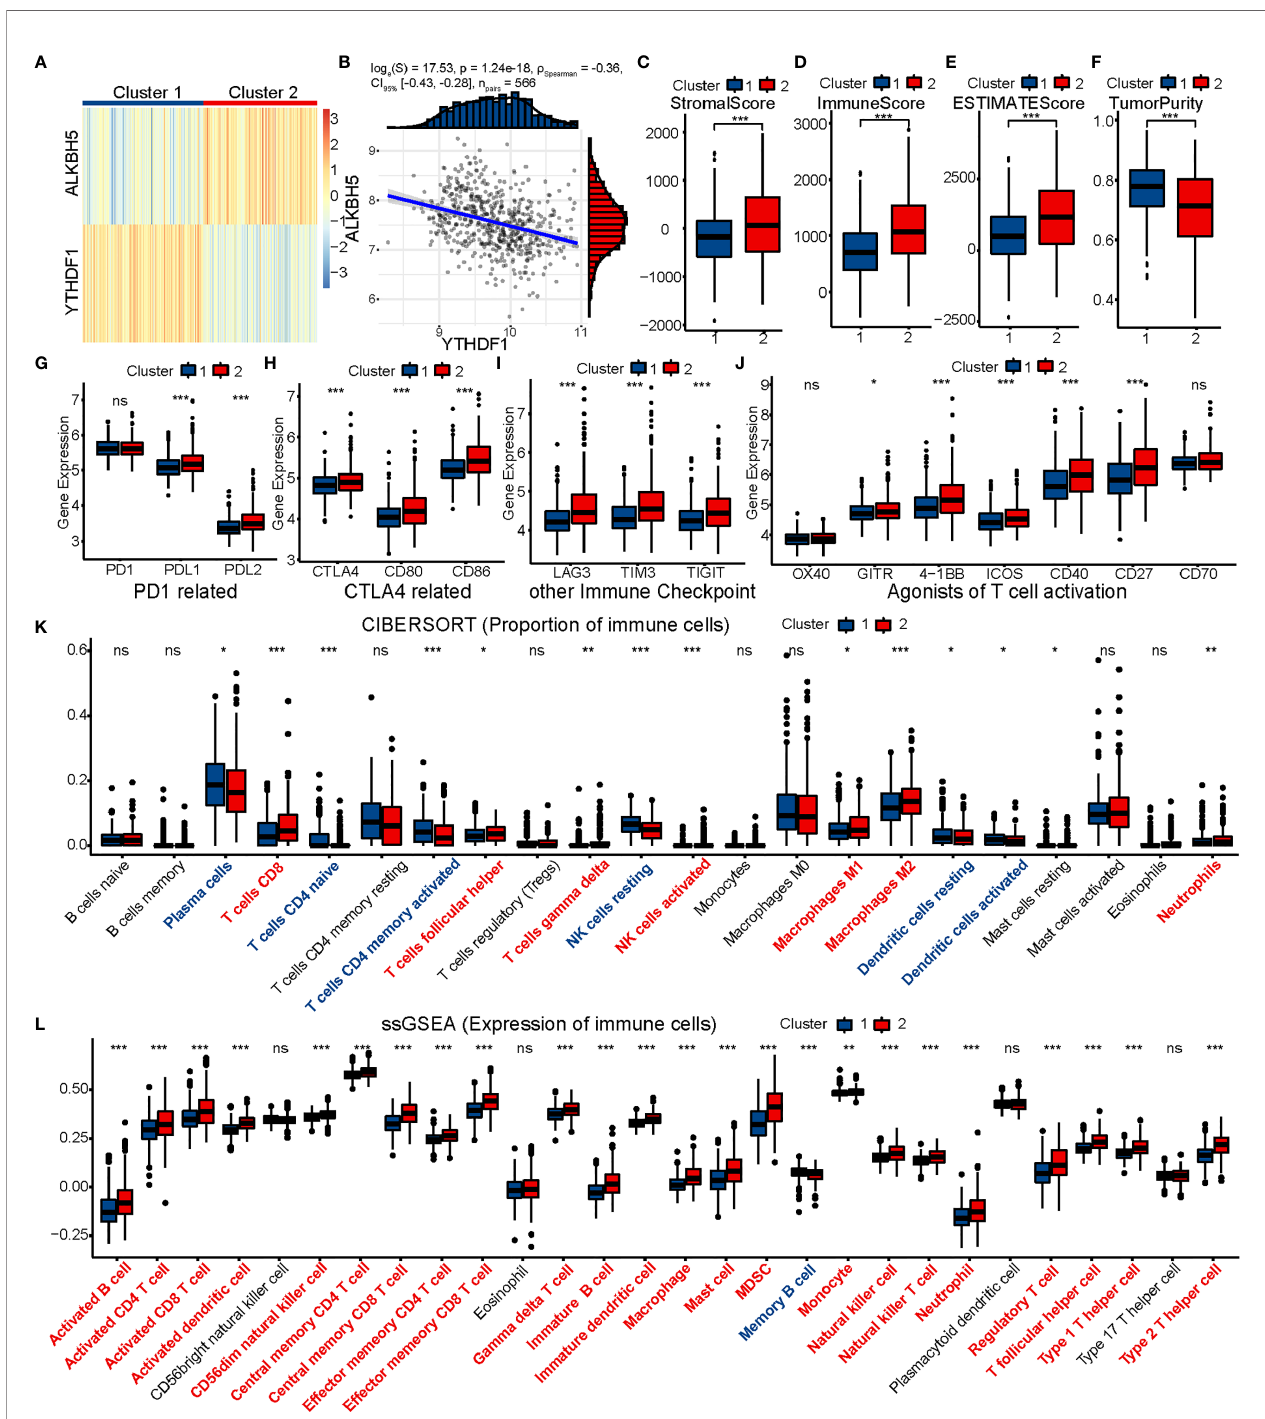
FIGURE 7 | GSE39582 validation of immune contexture between two clusters. (A) GSE39582 patients are divided into two clusters according to ALKBH5 and YTHDF1. (B) Association between ALKBH5 and YTHDF1 expression in GSE39582. (C – K) Comparison of stromal score (C) , immune score (D) , ESTIMATE score (E) , tumor purity (F) , targets of immunomodulatory drugs (G – J) , proportion of immune cells (K) and expression of immune cells (L) between two clusters. The P values are labeled using asterisks (ns, no signi fi cance, *P < 0.05, **P < 0.01, ***P <